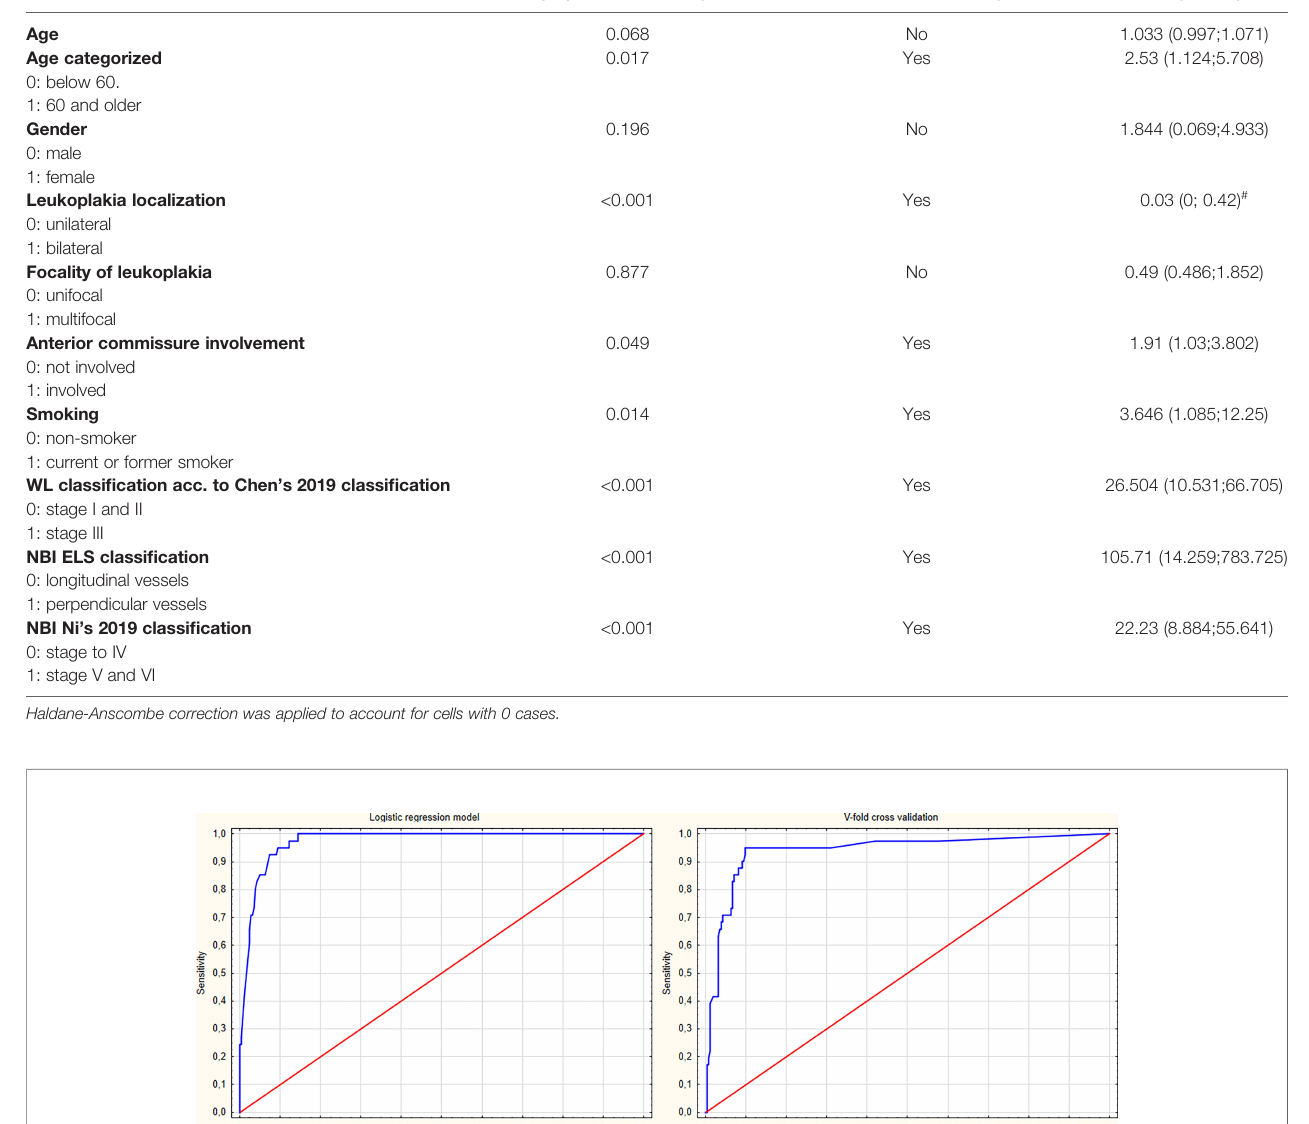
TABLE 1 | Summary of univariate analysis conducted as the fi rst step towards formulating a logistic regression model.